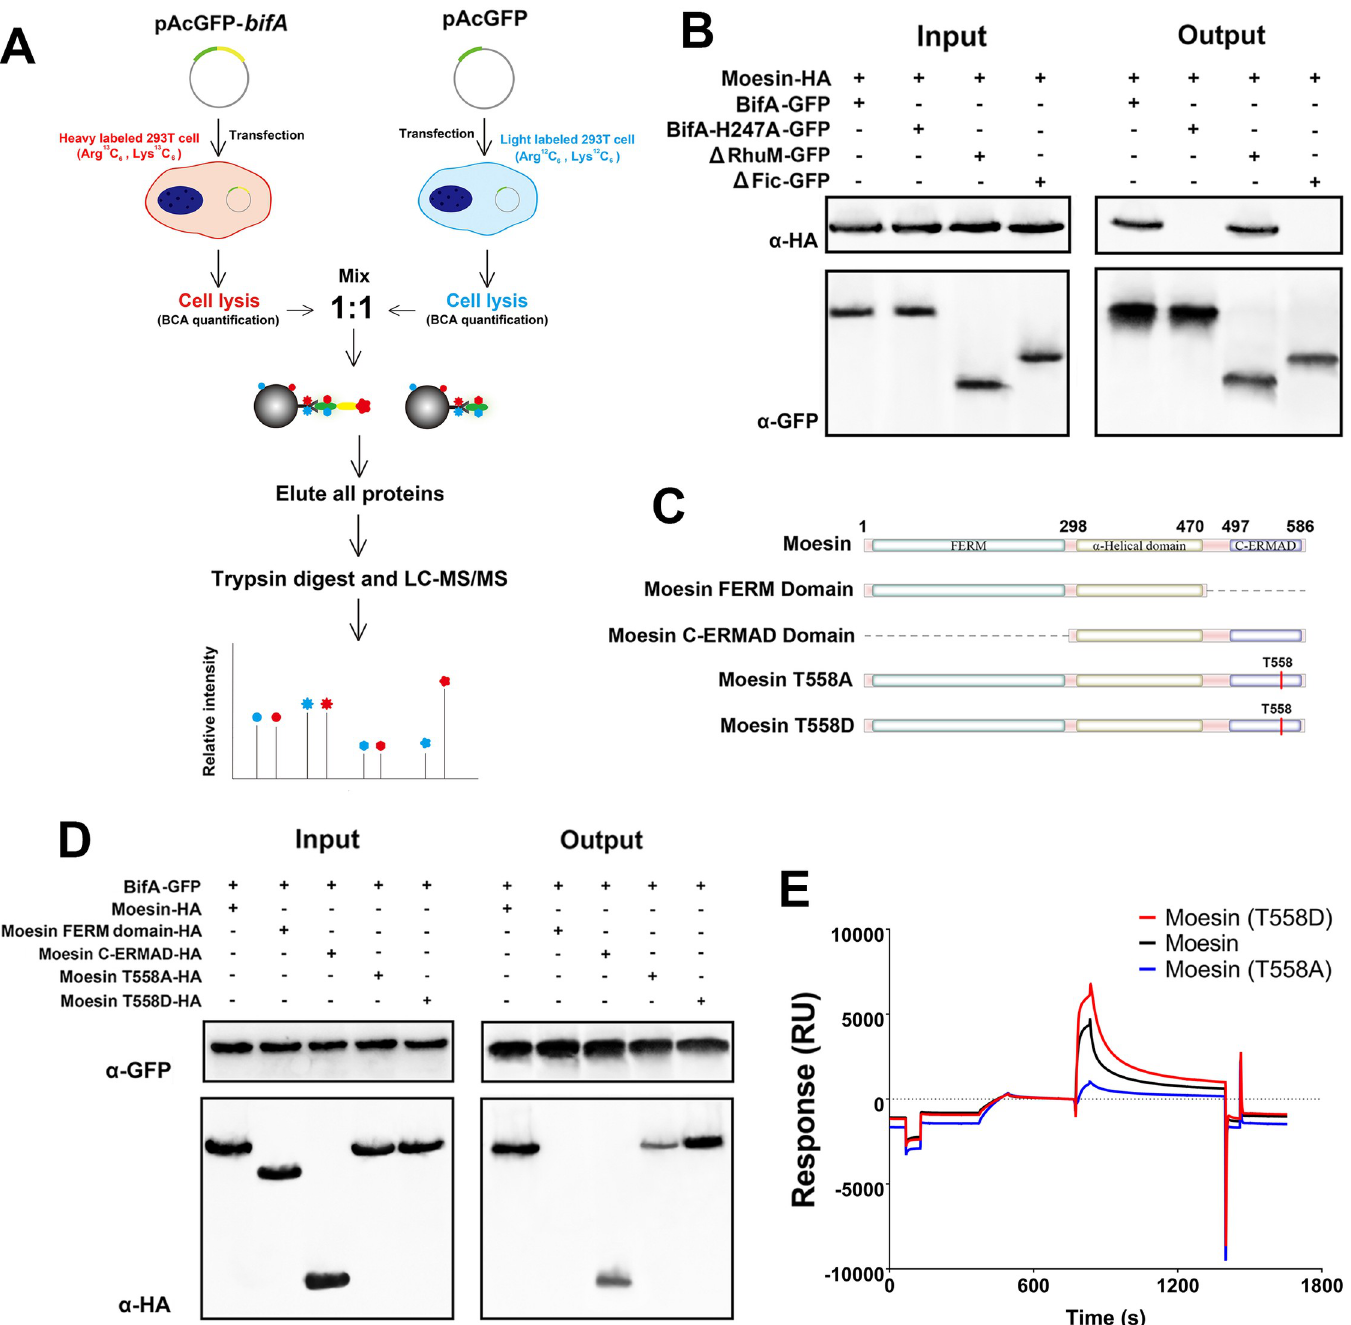
Fig 4. BifA interacts with moesin. (A) Schematic of proteomic strategy for identifying BifA binding partner(s). 293T cells were transfected with plasmids encoding GFP- tagged BifA or GFP alone, differentially labelled with heavy isotope (Arg 13 C 6 , Lys 13 C 6 ) or light isotope (Arg 12 C 6 , Lys 12 C 6 ), and GFP or GFP-BifA binding partners were compared by SILAC (see methods for details). (B) Co-immunoprecipitation of HA-tagged and GFP tagged BifA or its variants. Inputs are immunoblots of moesin and BifA in cell lysates prior to co-IP. Outputs are immunoblots of moesin and BifA in eluates after BifA immunoprecipitation. (C) Schematic of moesin variants for experiments in D and E. (D) Co-immunoprecipitation of GFP-tagged BifA and HA-tagged moesin variants, immunoblotted as in (B). (E) Surface plasmon resonance of the moesin-BifA interaction. The Y-axis shows response units (RU), where 1 RU is equivalent to a change in surface protein concentration of 1 pg/mm 2 .